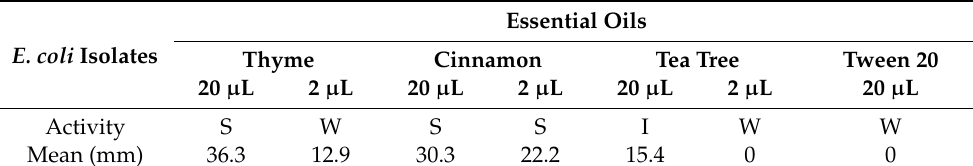
Table 6. Antimicrobial activity of three EOs (thyme, cinnamon, tea tree) on 23 strains of E. coli . Data interpretation in Section 4.7. Here are reported the mean halo diameter calculated for each column ± SD according to Mazzarrino et al. [26].